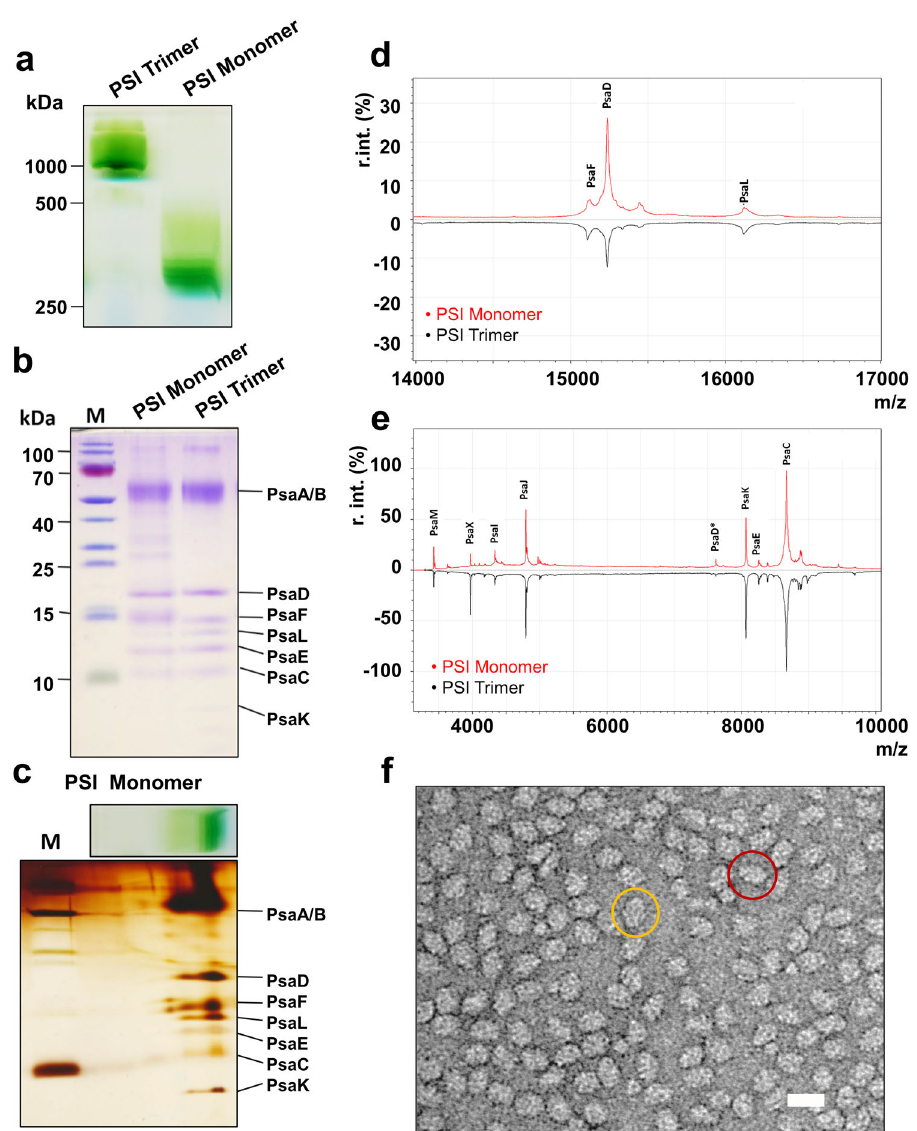
Fig. 1 Biochemical characterization of the puri fi ed PSI monomer complex from T. elongatus . a Blue-native (BN) PAGE of the PSI monomer next to a PSI trimer control (3.5 µ g Chl/lane). b SDS-PAGE of monomeric and trimeric PSI in comparison (2.5 µ g Chl/lane) c Two-dimensional (2D)-PAGE of monomeric PSI (3.5 µ g Chl/BN-lane). d , e MALDI-TO Fmass-spectrometry of monomeric and trimeric PSI complexes, mass range: d 14,000 – 17,000 m / z and e 3000 – 10,000 m / z (see also Table 1), *z = 2. f Negative stain EM image of PSI monomer with a top view encircled in yellow and a side view encircled in red. Scale bar corresponds to 20